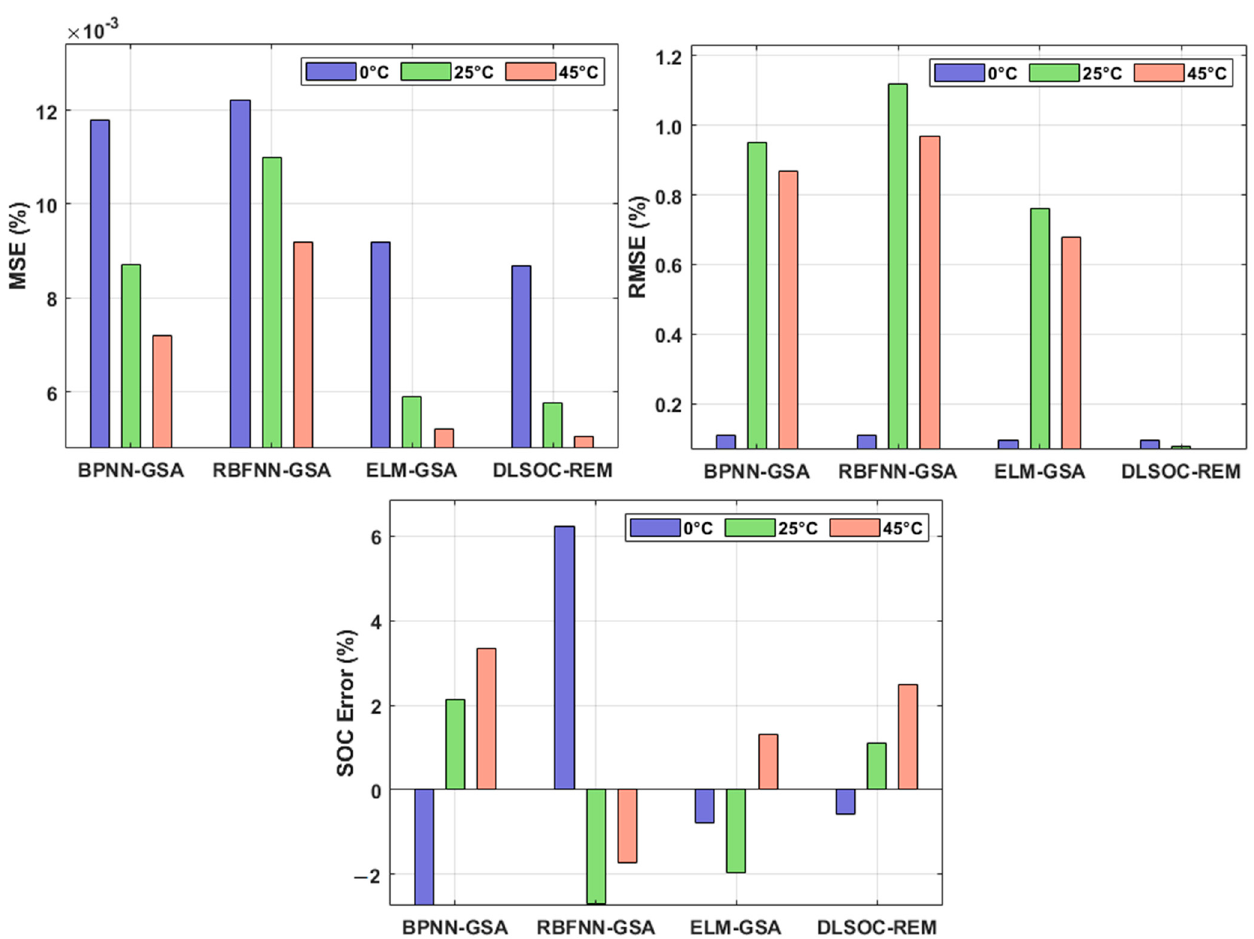
Figure 4. Comparative SOC estimation analysis of DLSOC-REM technique under BJDST drive cycle.